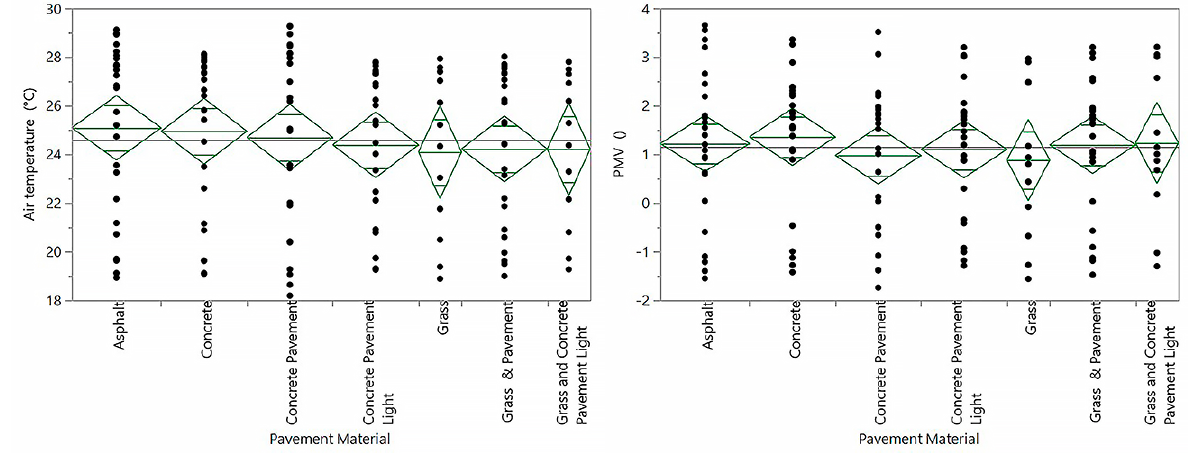
Figure 9. (a) Anova diagram of pavement material due to air temperature and